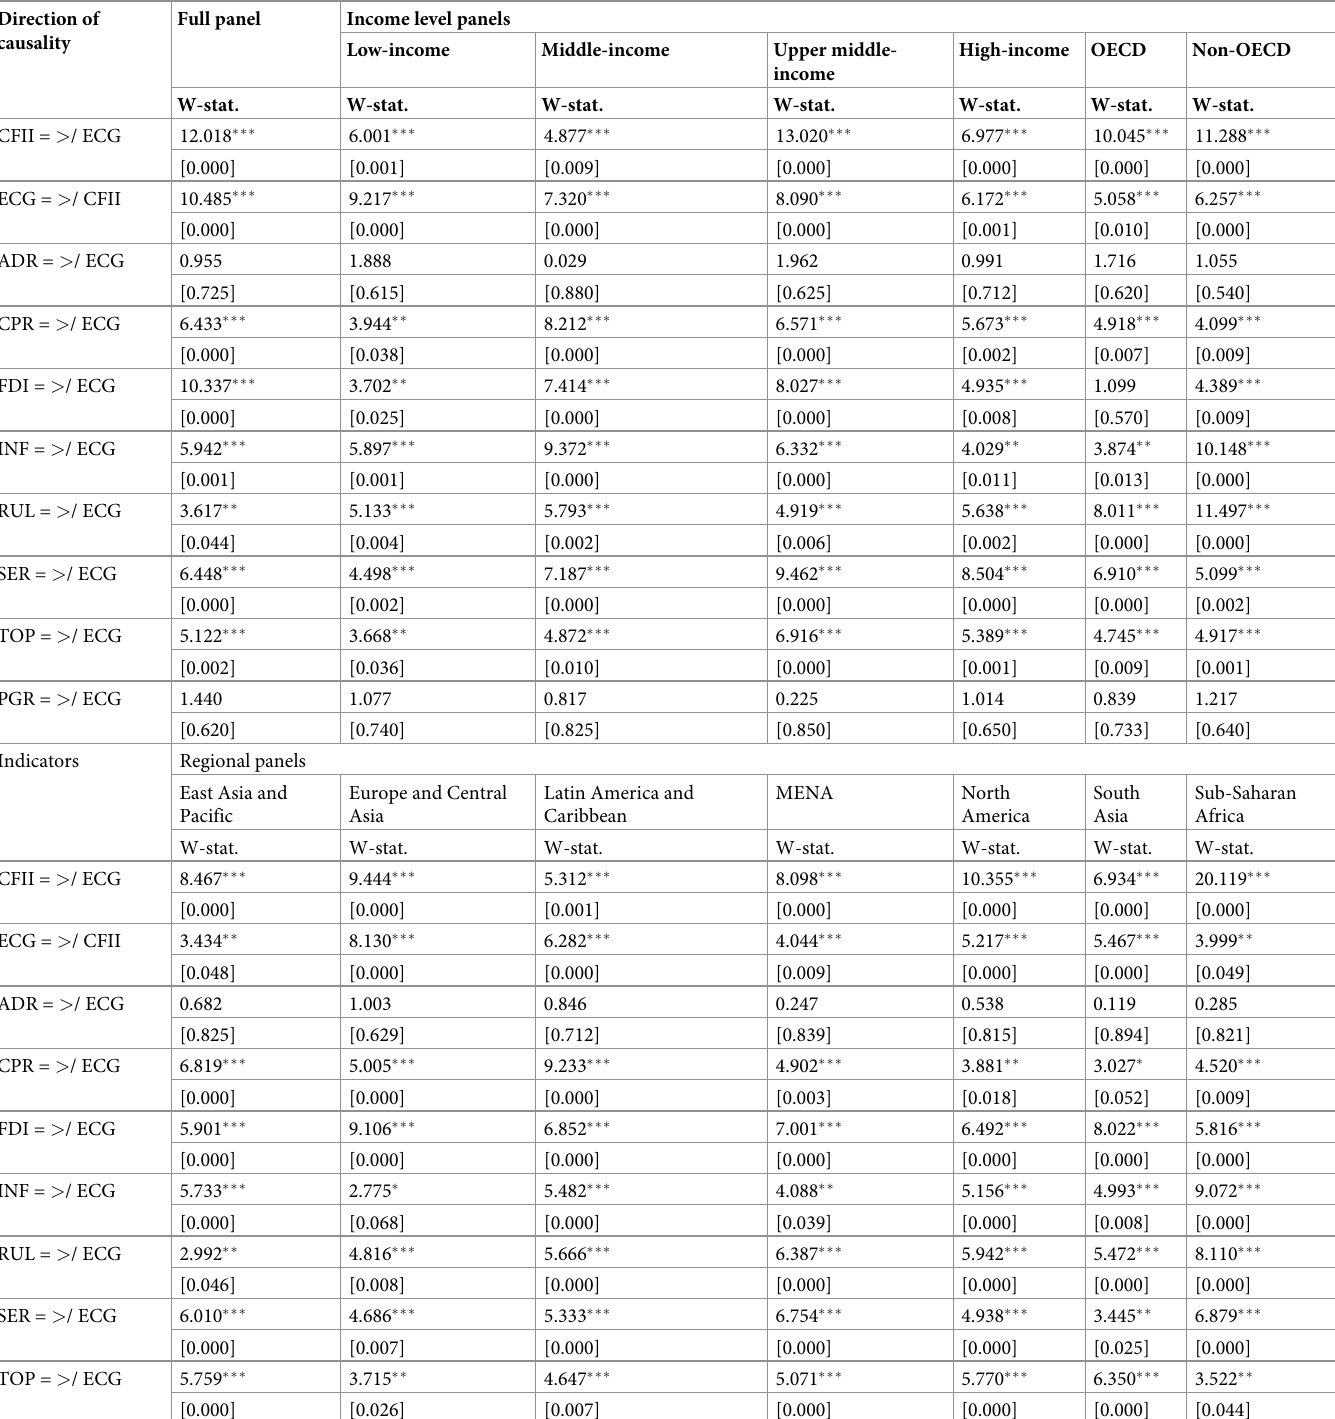
Table 5. Panel causality test results. Direction of